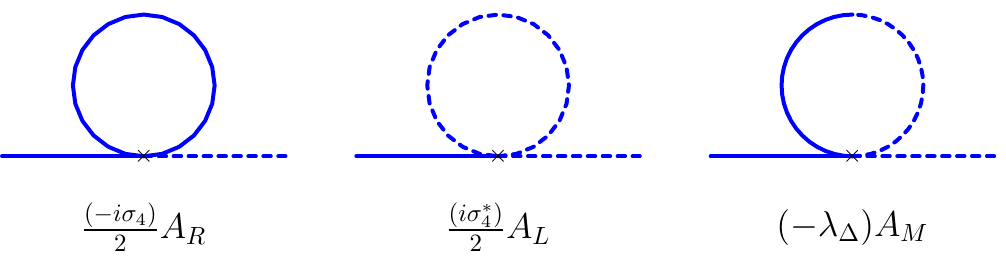
Figure 8. One loop correction to m 2